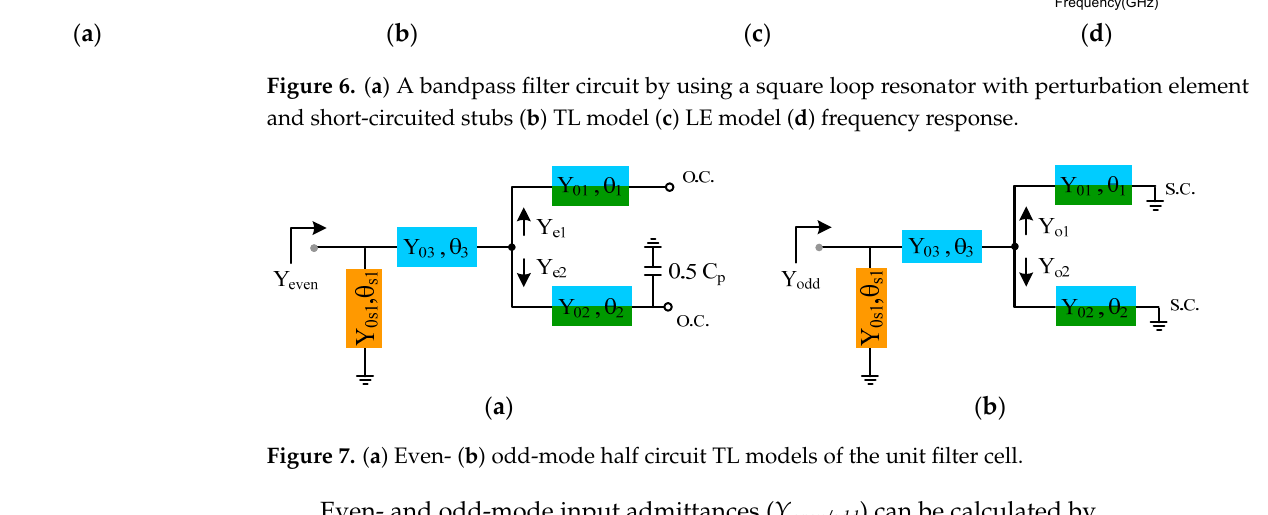
Figure 7. ( a ) Even- ( b ) odd-mode half circuit TL models of the unit filter cell. Even- and odd-mode input admittances ( Y even/odd ) can be calculated by, 1/ 1 ( Y + Y ) + j Y ( θ ) 1/ 1 (1) 03 tan 3 e1/o1 e2/o2 Y even/odd = − j Y 0s1 cot ( θ s1 ) + Y 03 where the electrical lengths of θ 1 and θ 2 are related to the top and bottom lines of the resonator, and their characteristic admittances are called Y 01 and Y 02 , respectively. θ 3 rep- resents the electrical length of the transmission line with characteristic admittance Y 03 . θ s1 is the electrical length of the short-circuited stub and Y 0s1 is the characteristic impedance of this stub. Y e1/o1 and Y e2/o2 are the admittances seen from the input of the top and bottom paths of the half circuit of the resonator under even- and odd-mode excitation, respec- tively. For even-mode excitation, these admittances are expressed by, e1